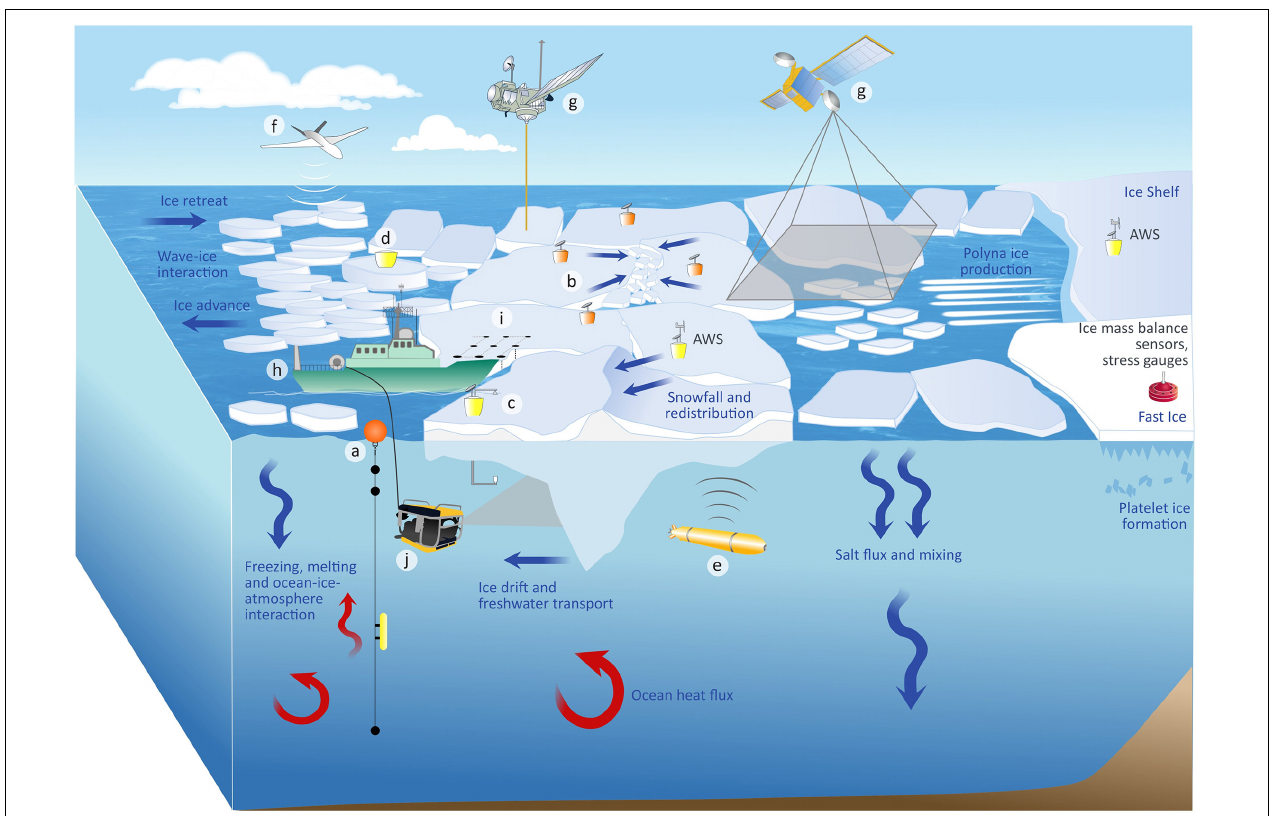
FIGURE 8 | Schematic of the platforms required to observe key sea-ice processes toward capturing circumpolar sea-ice variability (section “Toward a Better Understanding of Processes Controlling Antarctic Sea-Ice Variability and Change”) and deriving sea-ice thickness and volume (section “Observing Sea-Ice Thickness and Volume”). Due to the remoteness, vastness, and hostile conditions of the sea-ice zone, autonomous platforms will be crucial. They include high-resolution in situ sensors such as drifting buoys (a) ; ice-deformation arrays (b) , mass-balance- and snow-buoys (c) , wave buoys (d) , and autonomous underwater (e) and airborne vehicles (f) . Observations of snow depth, ice thickness, ice concentration, drift and properties from satellite altimeters, and radars and radiometers (g) are vital to sustain for long-term time series. Manned observation platforms include vessels (h) [for underway and in situ sea-ice sampling (i) including ROV deployments (j) ], aircraft (e.g., EMBird and NASA’s Operation IceBridge), and near-coastal research stations (for fast-ice and sea-ice/ice-shelf studies). Modified from Meredith et al. (2013).